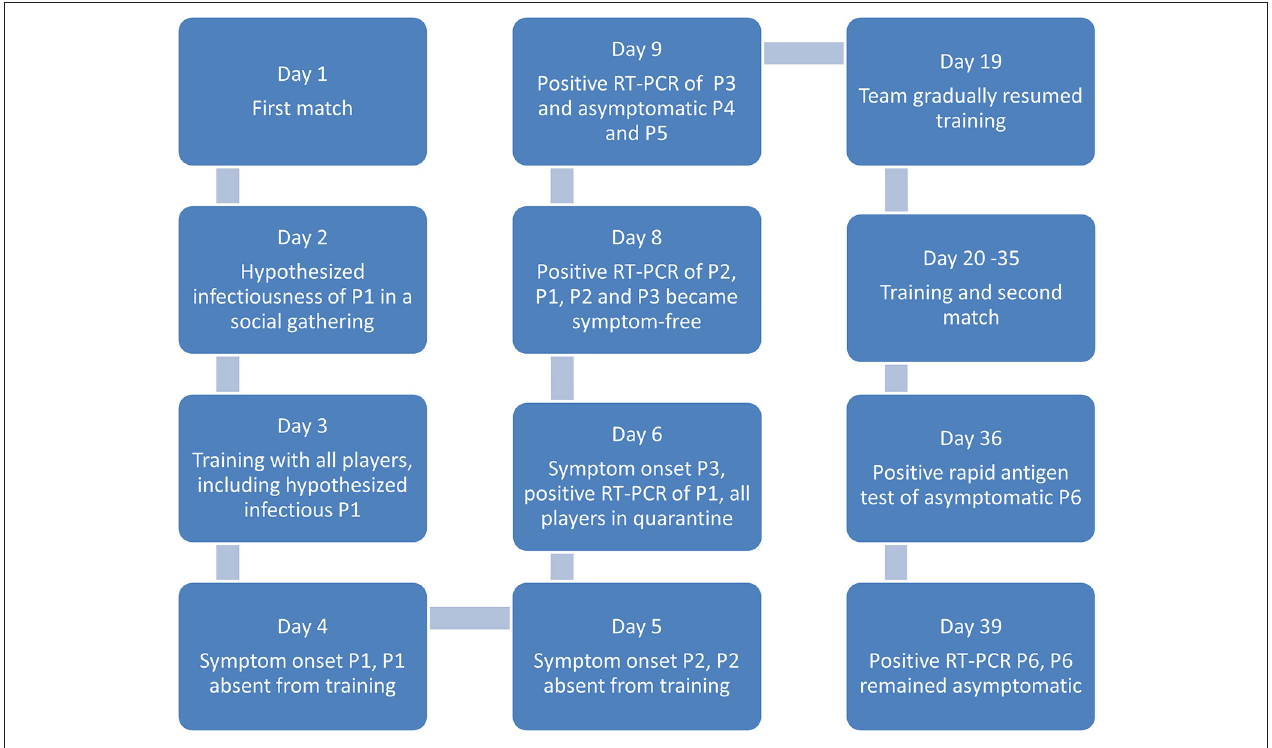
FIGURE 1 | Course of infection within the